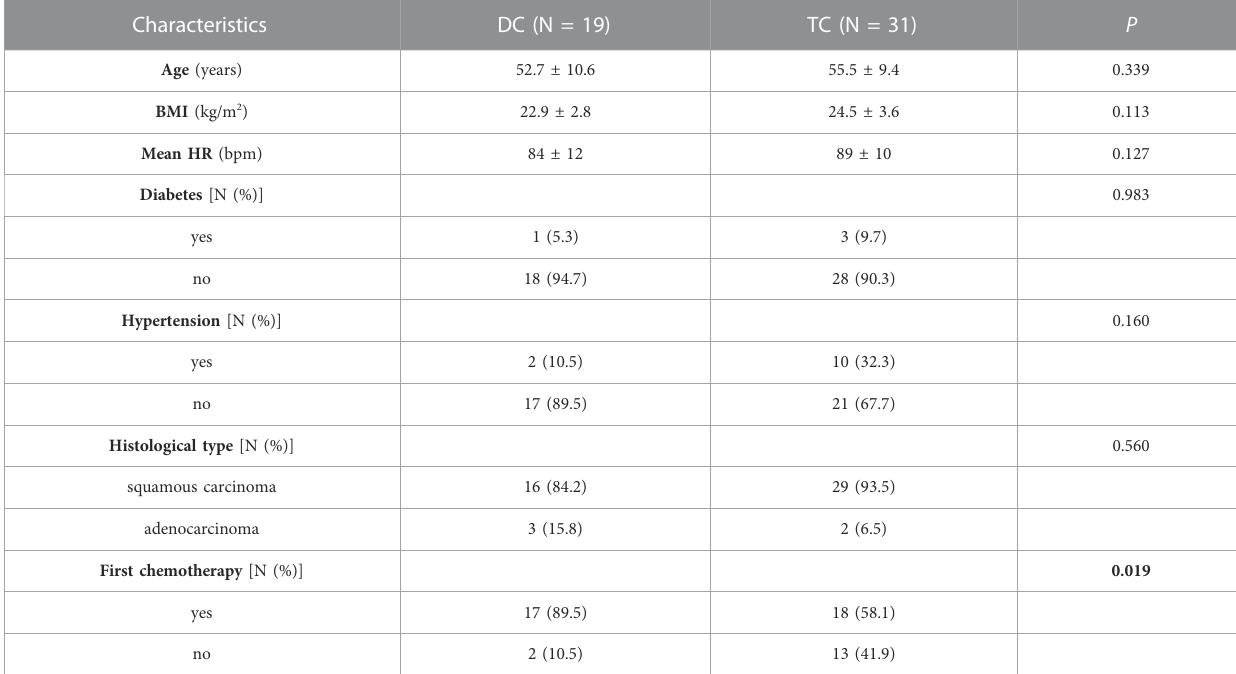
TABLE 1 Clinical and demographic data.